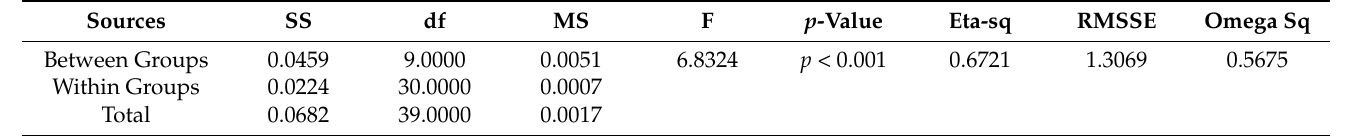
Table A2. ANOVA results regarding the F1-scores of various categories.